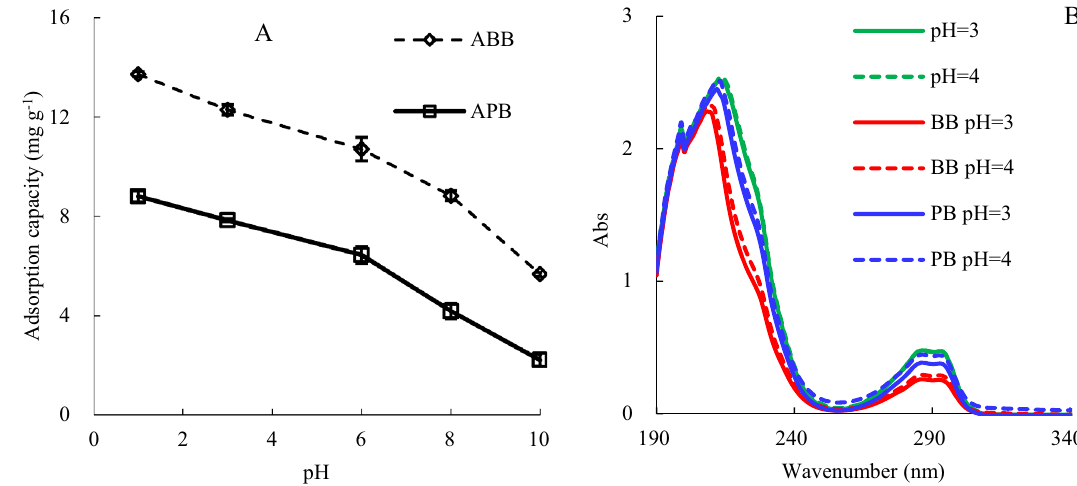
Figure 4. Effects of initial pH on 2,4,6-TCP adsorption ( A ) the biochars adsorption capacity with different solution pH; ( B ) Abs of band ultraviolet scanning with different 2,4,6-TCP solution pH.